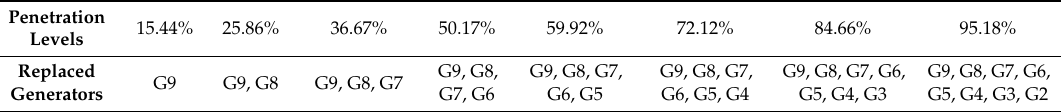
Table 2. Replaced units and corresponding penetration levels in the New England test system (NETS) area.